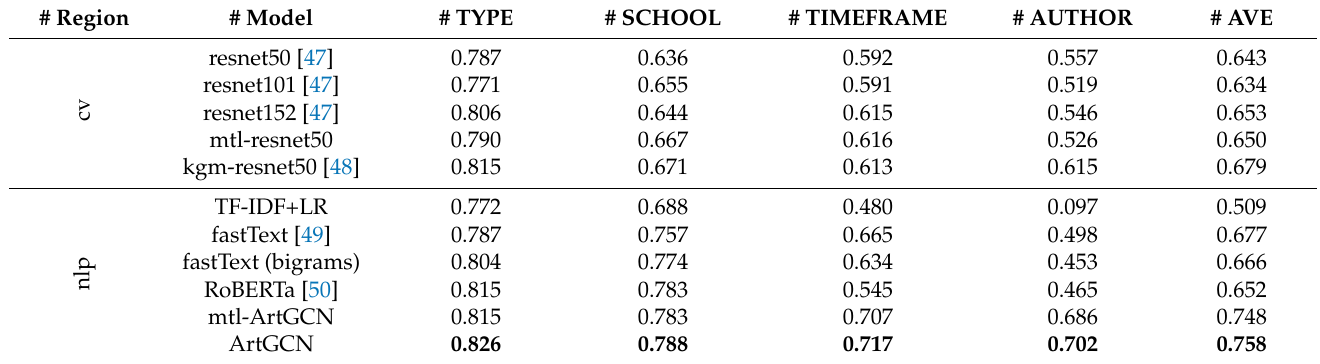
Table 2. Art classification results on SemArt